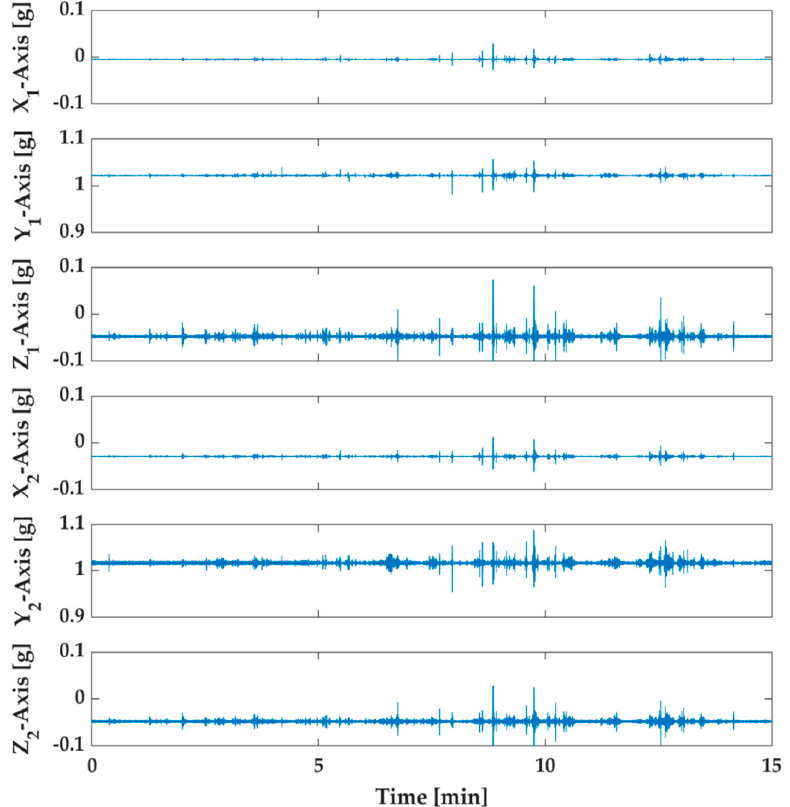
Figure 6. Six axes acquired data through the proposed monitoring system of the undamaged structure. The first three measurements are related to sensor 1 (X 1 , Y 1 , Z 1 ), and the others are from sensor 2 (X 2 , Y 2 , Z 2 ).